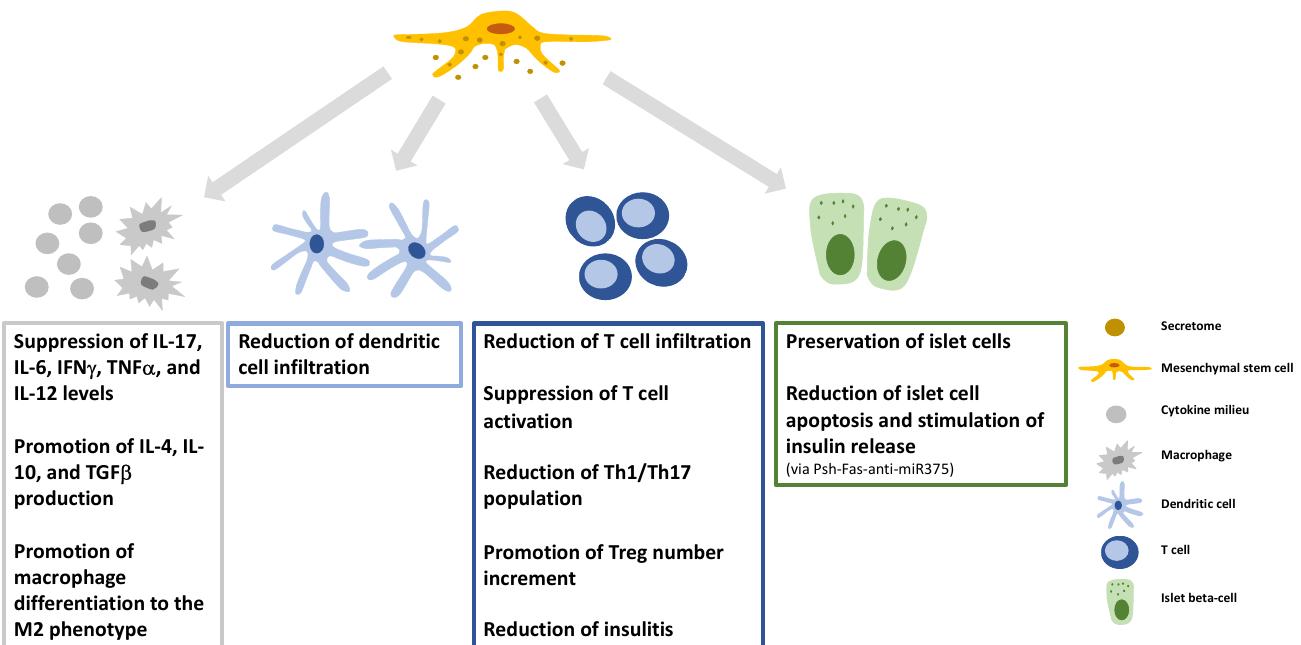
Figure 5. The potential modes of beneficial action of the MSC-secretome in type 1 diabetes mellitus (T1DM). The figure shows how MSC-secretome contributes to the restoration of immune dysregula- tion in T1DM (IL: interleukin; TNF: tumor necrosis factor; IFN: interferon; TGF: transforming growth factor; Treg: regulatory T cell; Th1/Th17: type 1/type 17 helper T